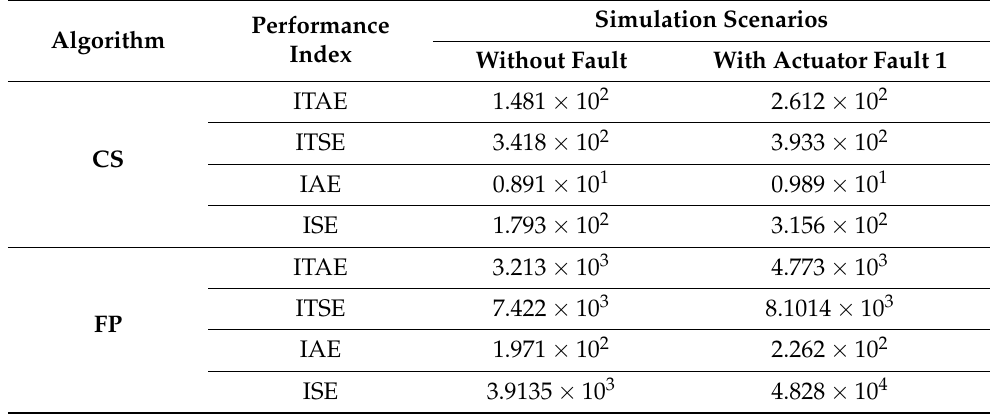
Table 2. Results of average performance index of minimums values found by the CS and FP algorithm using ST2FIS.